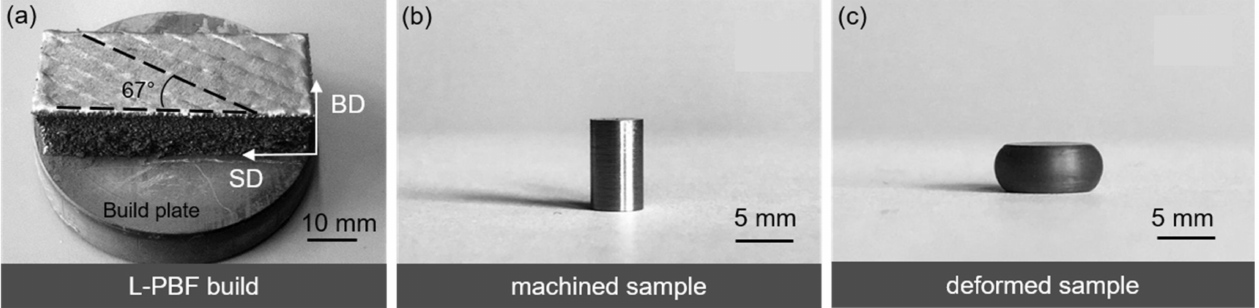
Figure 2. The Fe-25Al-15Ta build printed by L-PBF using P = 250 W and vs. = 1000 mm/s ( a ), wire EDM sample ( b ), and compressed specimen deformed at 1000 ◦ C/0.001 s − 1 ( c ). The BD and SD refer to the building and scanning directions.